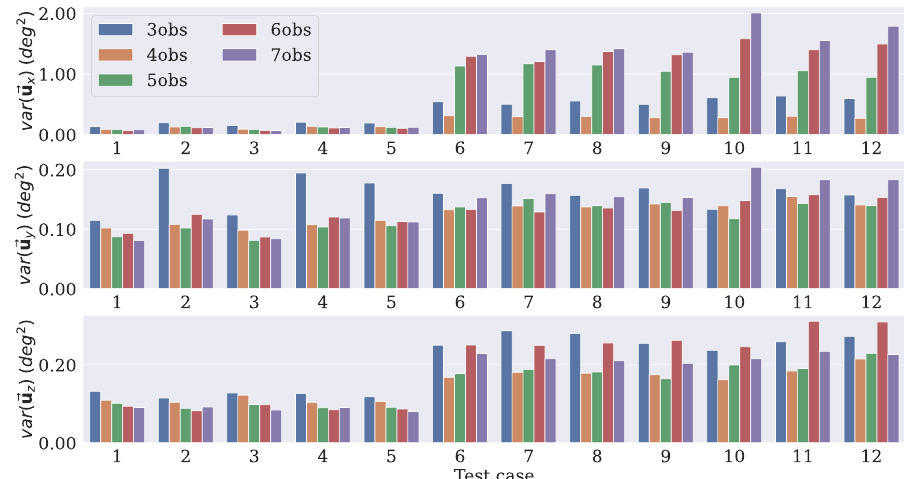
Figure 5. Uncertainties in the axes for each test case considering a dropout rate of 15%.